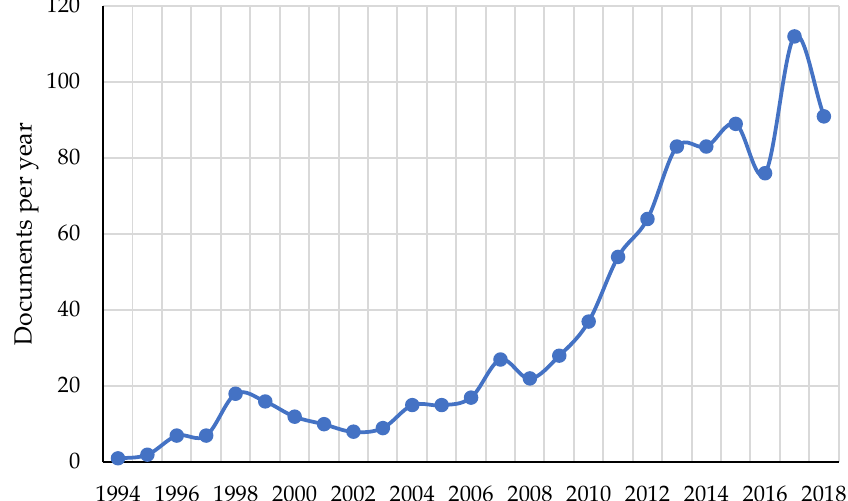
Figure 2. The time distribution of the articles on multifunctionality in LCA published in scientific journals per year retrieved from Scopus.